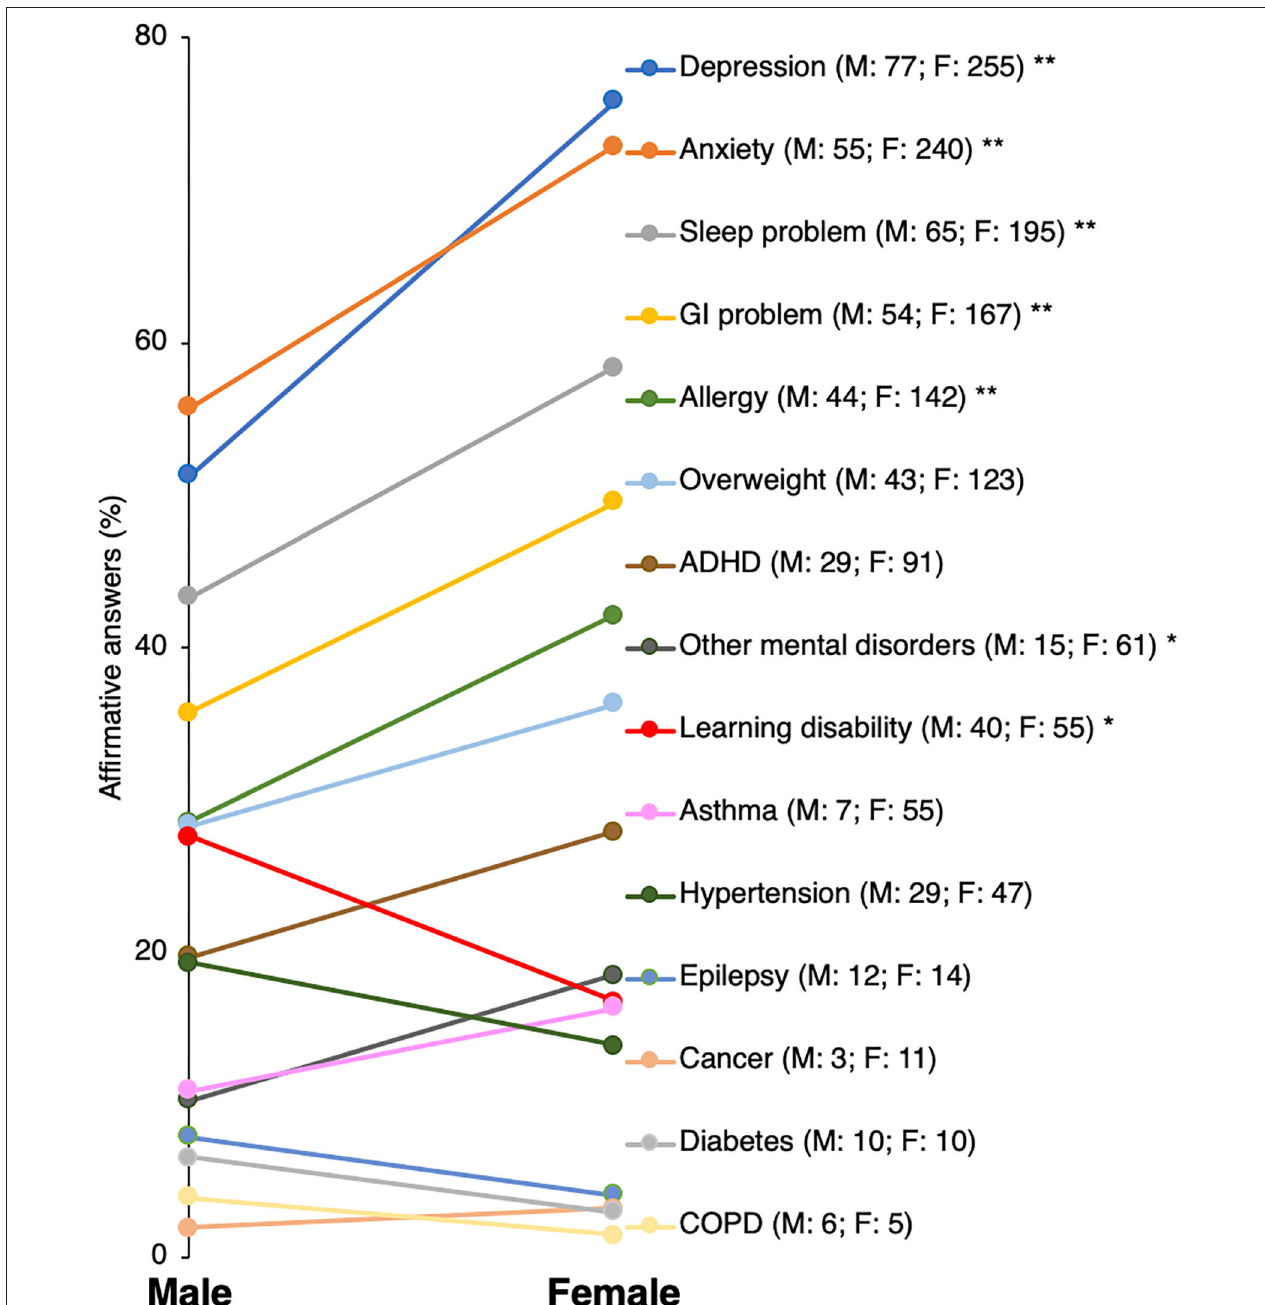
FIGURE 2 | Differences in rates of chronic health conditions reported by autistic adult males and females. GI, gastrointestinal; COPD, chronic obstructive pulmonary disease; ADHD, attention-deficit hyperactivity disorder. * p < 0.05; ** p < 0.005. respectively) believed that these reasons for hospital contact were more frequent in autistic adults than non-autistic adults ( Figure 4 ; Table 2